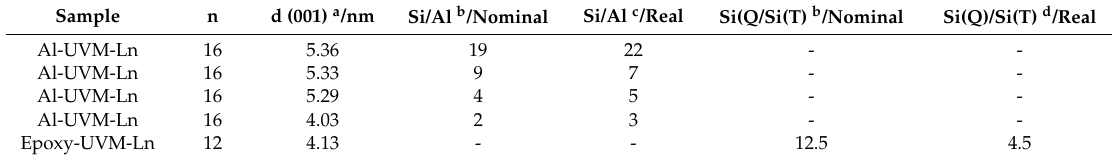
Table 2. Selected physical parameters for UVM-Ln functionalized